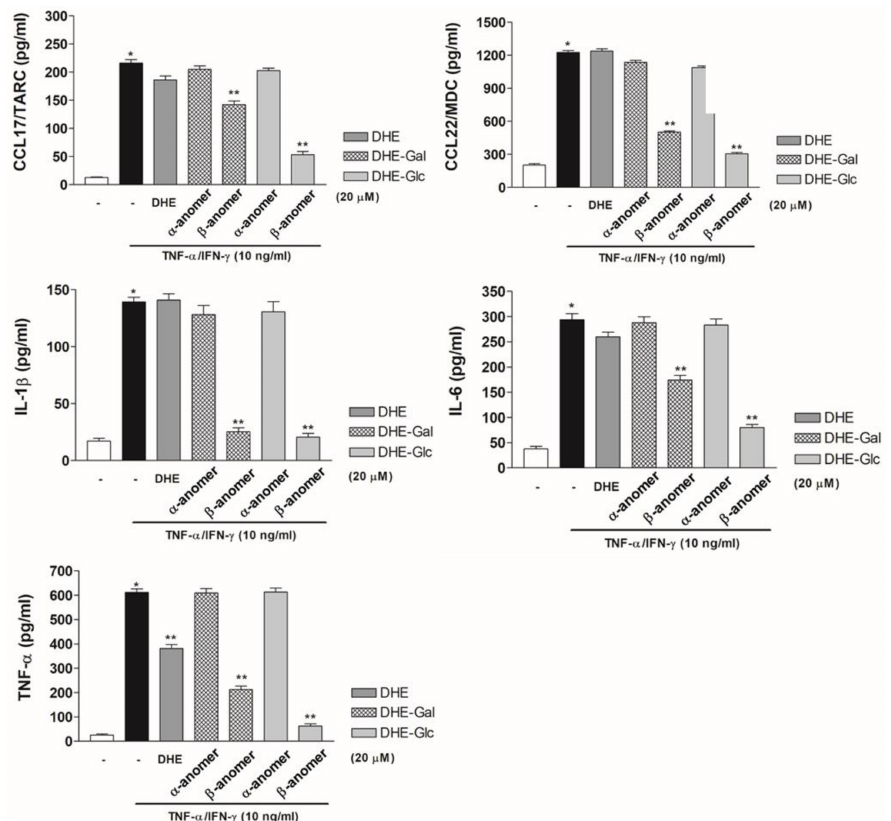
Figure 4. Effects of DHE-glycoside α - and β -anomers on pro-inflammatory cytokine and chemokine protein expression. To determine the effects of synthetic DHE-glycoside α - and β -anomers on IL-1 β , IL-6, and TNF- α protein expression, protein expression was determined using ELISA assays. CCL17 and CCL22 protein expression was determined under same conditions. The values for protein expression intensity are the mean ± S.D. of three independent experiments ( n = 3). * p < 0.01 compared to mock medium alone, ** p < 0.01 compared to treatment with TNF- α /IFN- γ